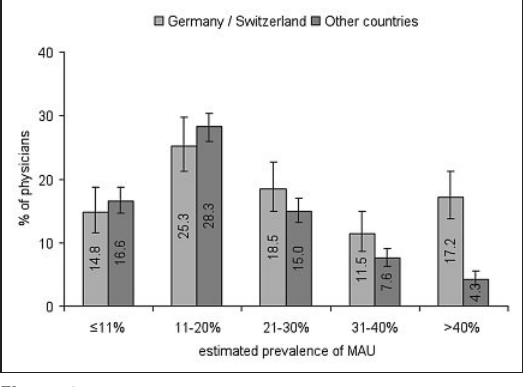
Figure 1 Mean prevalence estimates [95% CI].